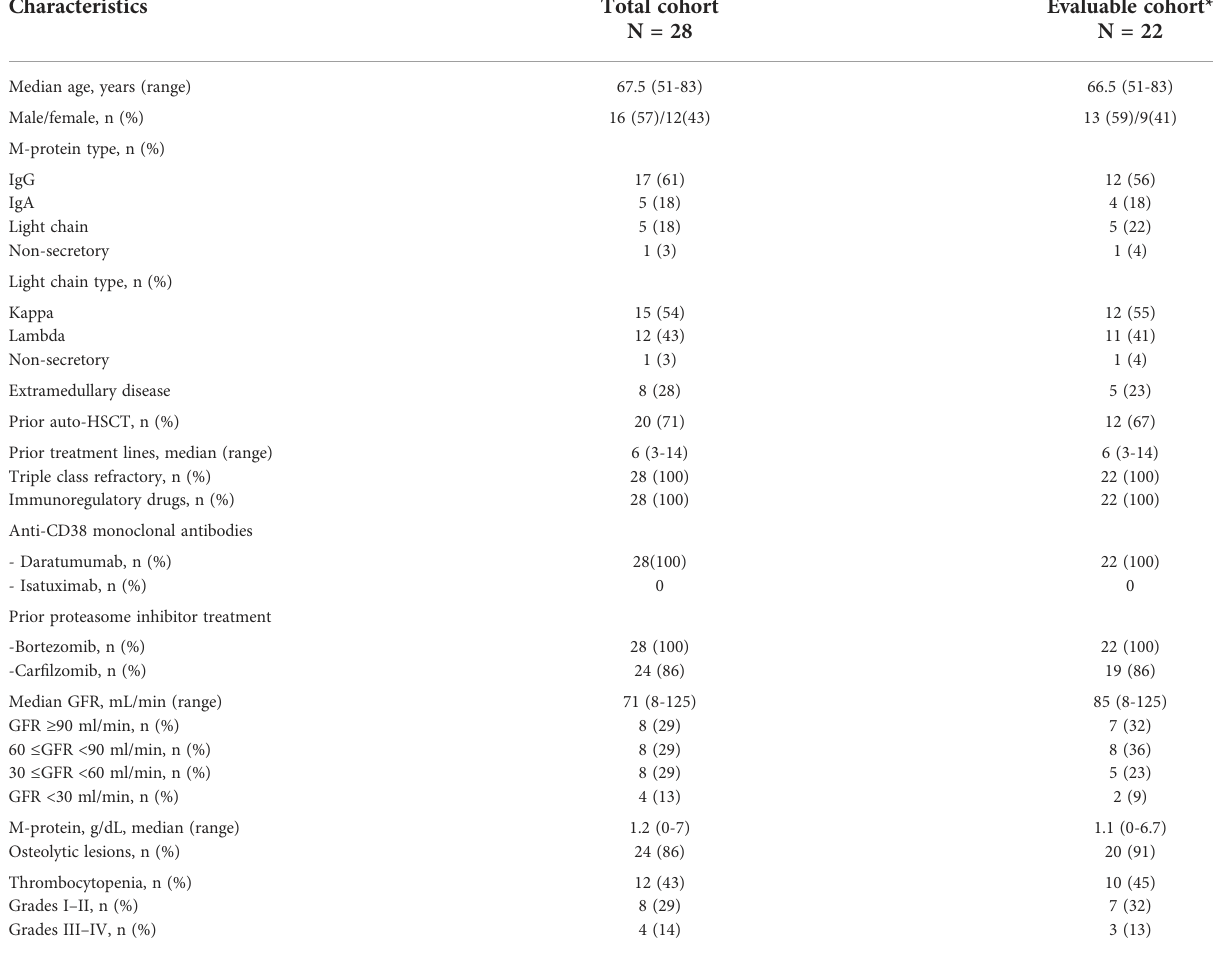
TABLE 1 Patients ’ characteristics prior belantamab-mafodotin administration.